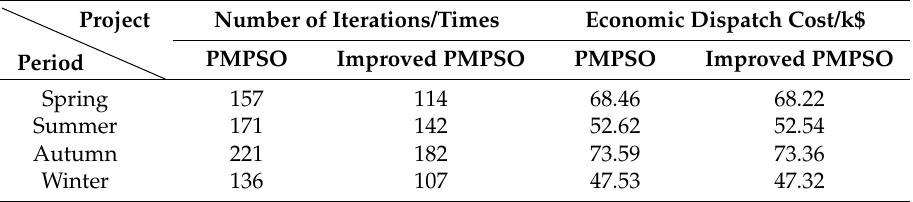
Table 5. Comparison between PMPSO algorithm and improved PMPSO